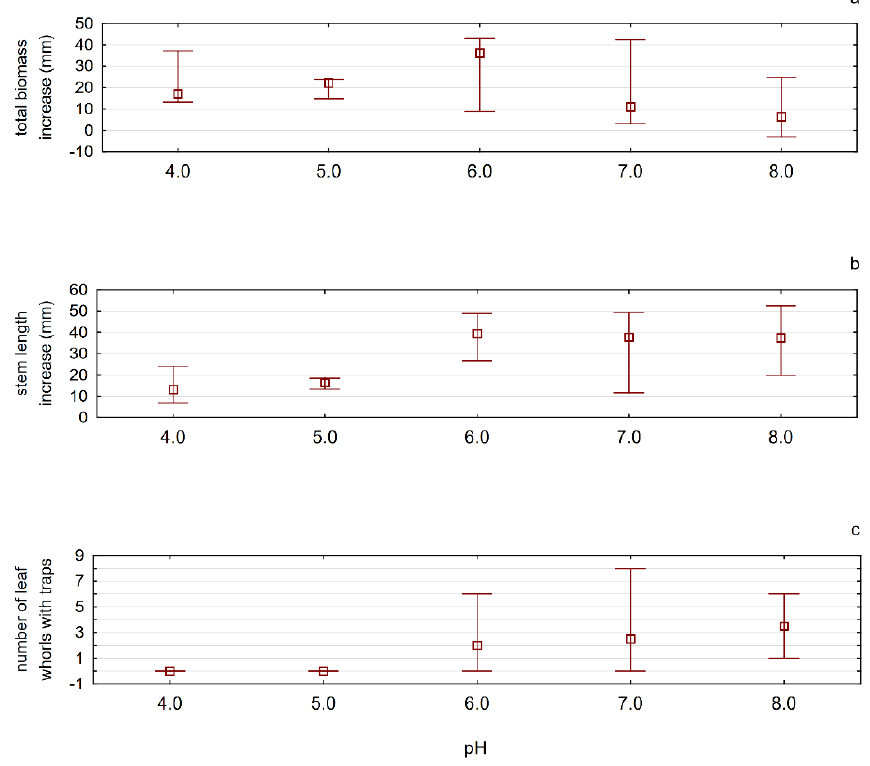
Figure 6. The influence of different values of the solution pH on the tested plant features, determining the effectiveness of its growth in laboratory conditions (( a )—total biomass increase, ( b )—stem length, ( c )—number of leaf whorls with traps). Whiskers indicate the range of values, and squares indicate the median.